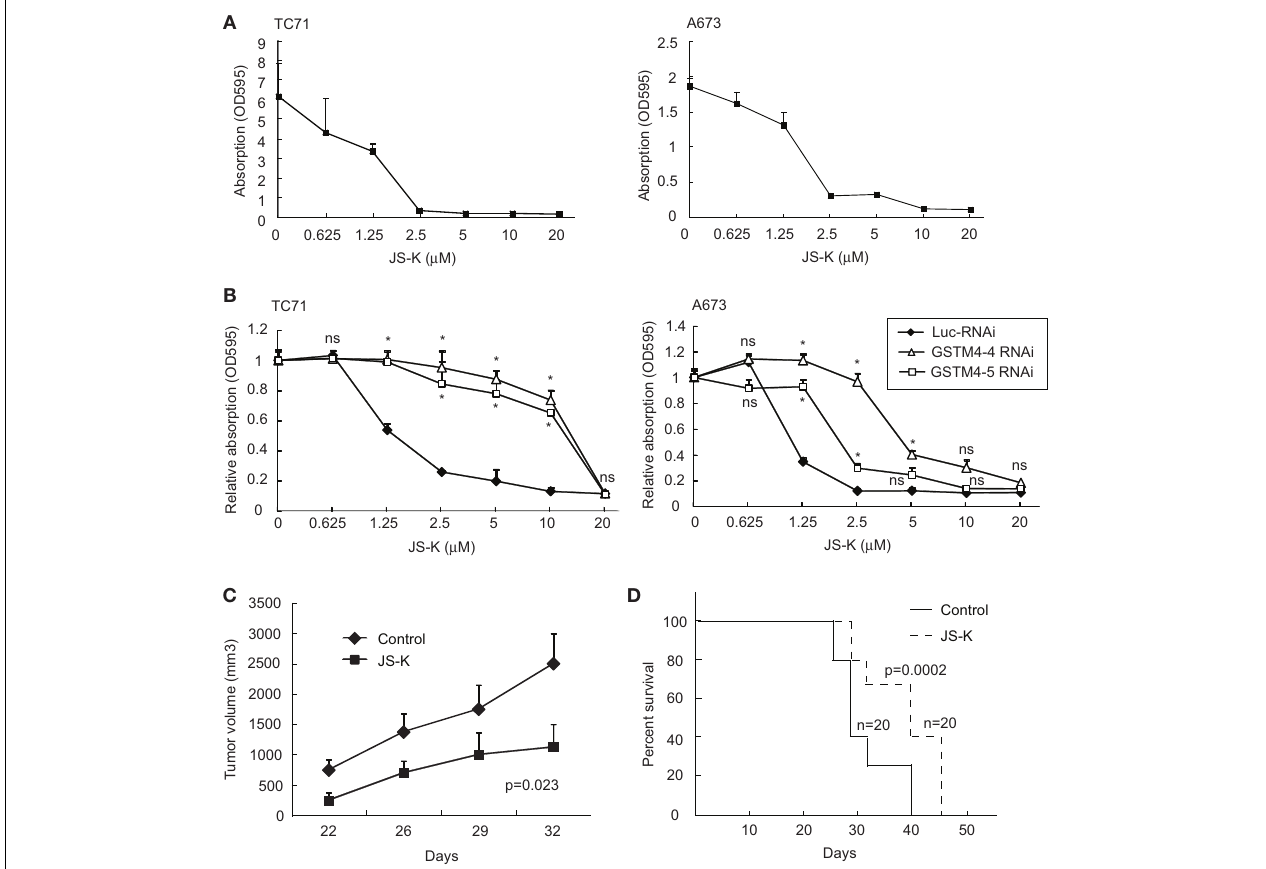
representative repeat are shown as means ± SD of technical duplicate. Asterisk indicates that the difference between control-silenced and GSTM4-silenced cells is significant ( p < 0.05); ns, not significant. (C) JS-K inhibits Ewing sarcoma xenograft tumor growth in immunodeficient mice. TC71 cells were injected subcutaneously into both flanks of nude mice. JS-K was administered via tail vein injection the day after cell injection every other day for 2weeks.Tumor growth was monitored by caliper measurement twice a week.The experiment was repeated four times and results of one representative repeat are shown as means ± SD of 10 tumors in each group. ANOVA test, p = 0.023. (D) Overall survival of vehicle or JS-K-treated mice harboring tumor xenografts. Kaplan–Meier survival curve was plotted using GraphPad Prism. Mantel–CoxTest, p =